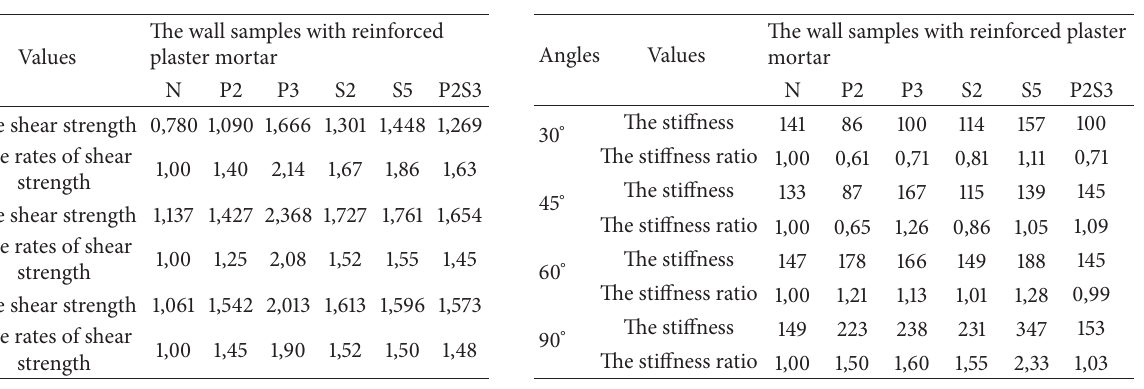
Table 3: The shear strengths of the walls. Table 4: The stiffness values of the wall